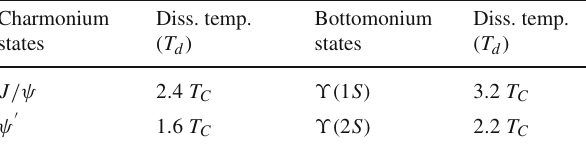
√ s NN = 2 . 76 TeV. Experi-